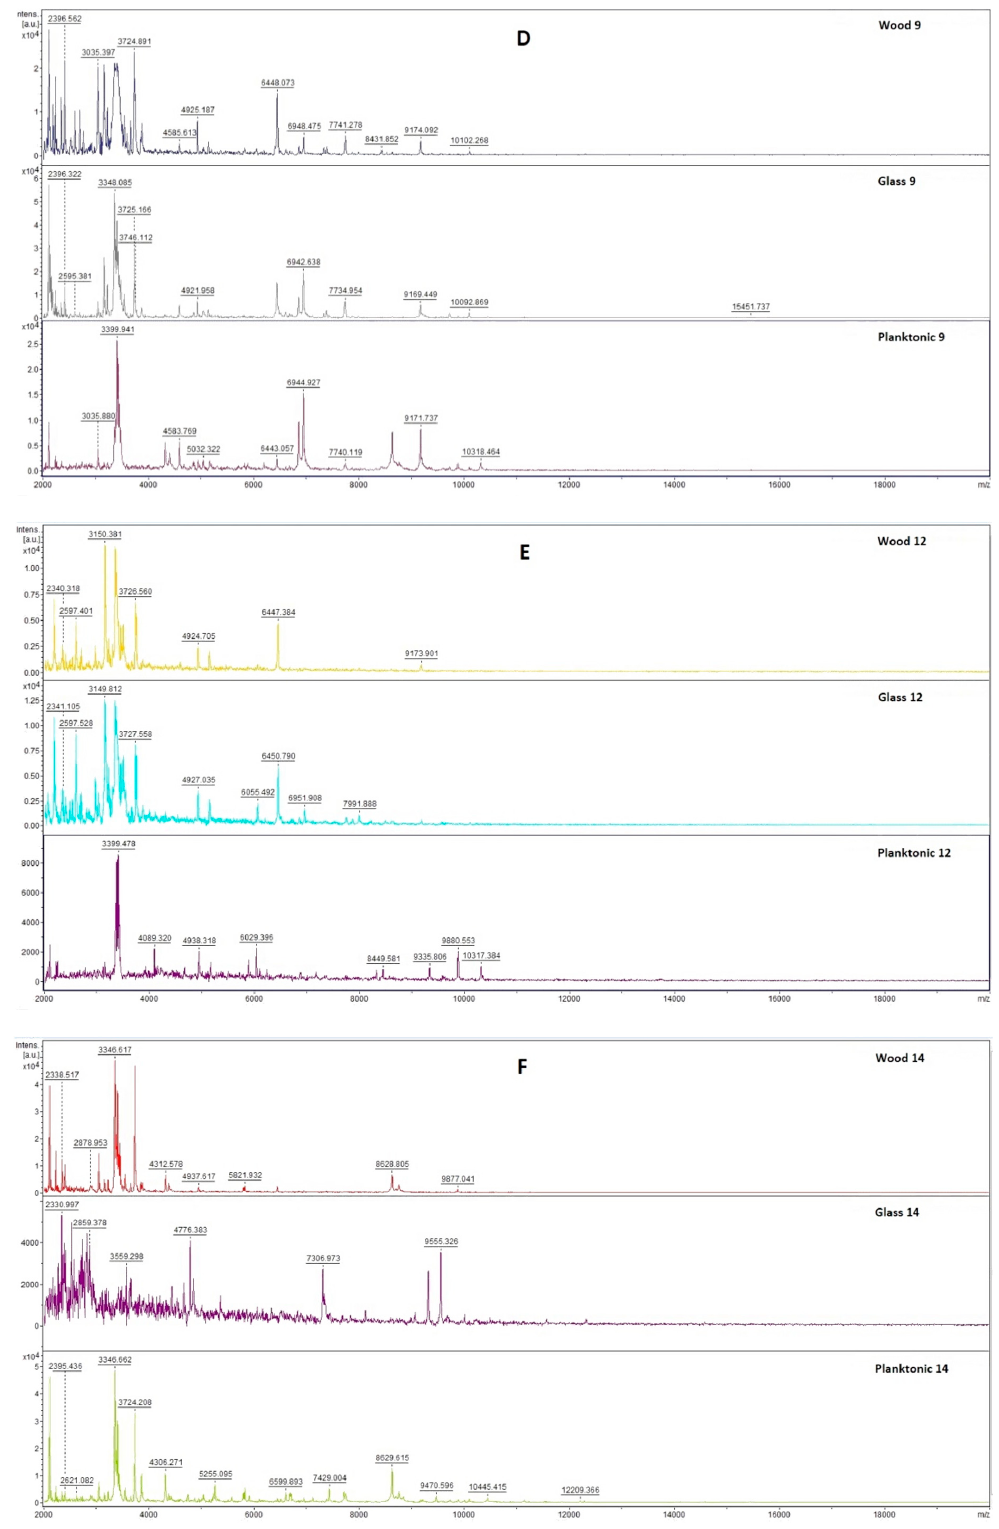
Figure 1. MALDI-TOF mass spectra of S. maltophilia biofilm during development: ( A ) 3rd day, ( B ) 5th day, ( C ) 7th day, ( D ) 9th day, ( E ) 12th day, and ( F ) 14th